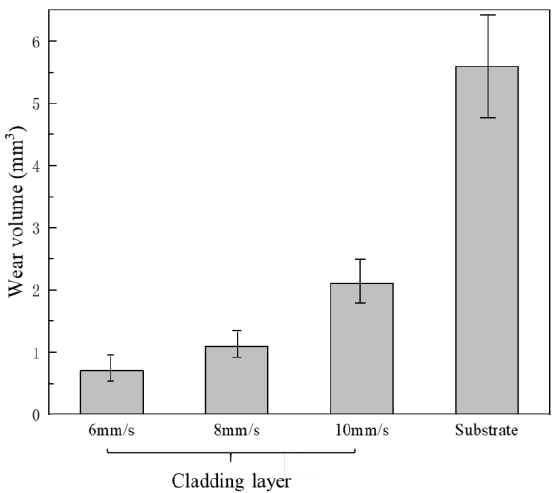
Figure 9. Volume losses in the wear tests for the substrate and the cladding layers produced with different scanning speeds.